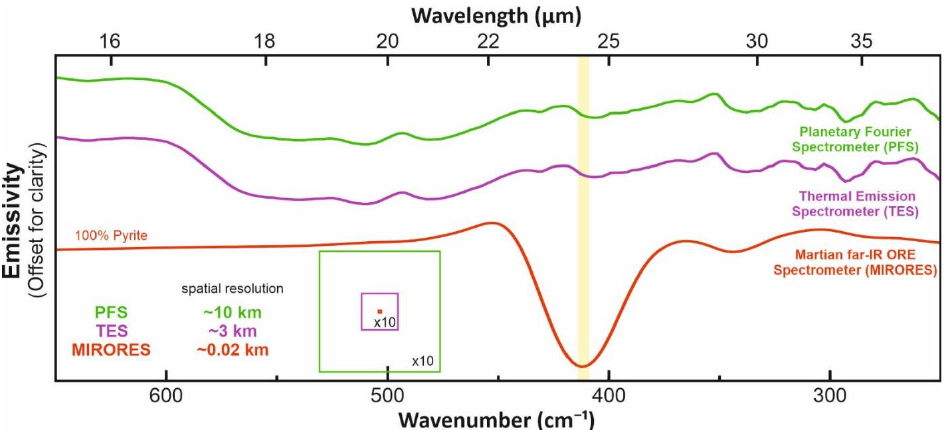
Figure 2. Simulation of observed emissivity spectra from 20 m × 20 m field covered by pyrite and surrounded by infinite area of basalts with shergottitic composition (see Section 3) as recorded by the Planetary Fourier Spectrometer (PFS), Thermal Emission Spectrometer (TES), and our MIRORES spectrometer. The simulations show that the orebodies similar in size to those on Earth would be impossible to detect with the far-IR spectrometers currently orbiting Mars due to the low spatial resolution of the spectrometers (see the bottom left corner of the